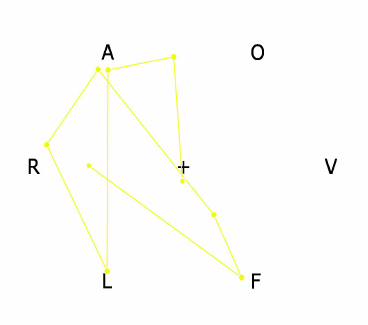
Figure 1. A sample stimulus with a 6-letter anagram overlaid with a partial gaze trajectory of a participant. The experiment started with the participant looking at the central fixation point (+ symbol), and the gaze moved to the top of the screen. Then, the participant looked directly at the letter A followed by L and R and so forth. The letter sequence inferred from this data would be ALRAFR. The fixation locations can be sometimes ambiguous, but moving letters farther apart and lowering the contrast improved the data quality.